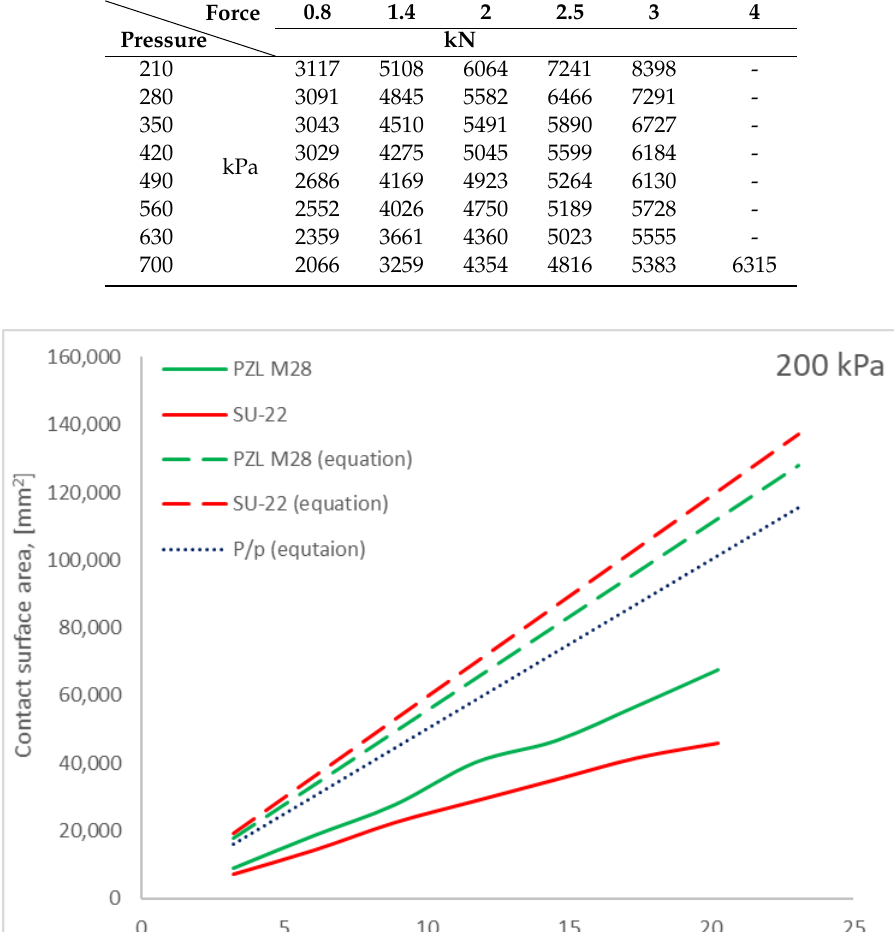
Table 6. Surface area values resulting from testing the ASFT device-T520 retreaded tire (results in mm 2 ).